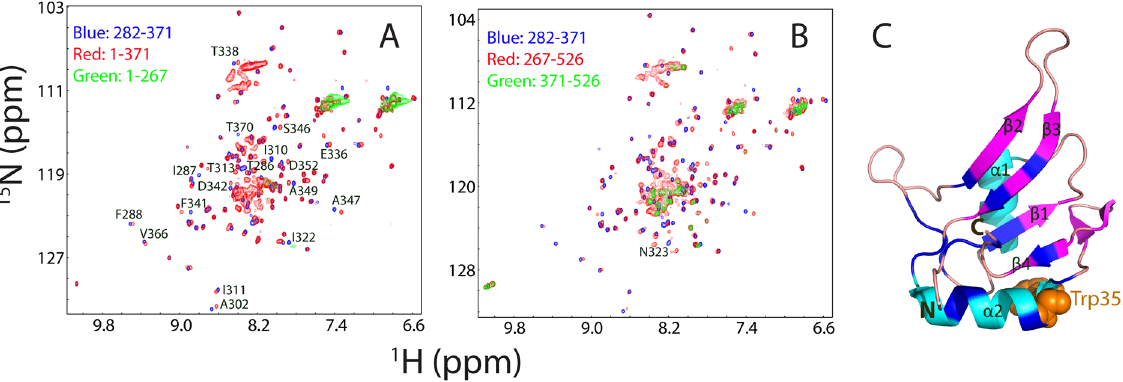
Figure 4. NMR characterization of two RRM-containing fragments. ( A ) Superimposition of HSQC spectra of FUS (1–267), FUS (1–371) and FUS (282–371) in 1 mM phosphate buffer at pH 6.8. The residues with significant shifts of HSQC peaks are labelled for the RRM domain in the isolated state and in the context of FUS (1–371). ( B ) Superimposition of HSQC spectra of FUS (371–526), FUS (267–526) and FUS (282–371) in 1 mM phosphate buffer at pH 6.8. ( C ) NMR structure of the FUS RRM previously determined (PDB ID of 2LCW). The residues with significant shifts of HSQC peaks are colored in blue. The sole Trp353 is displayed as brown